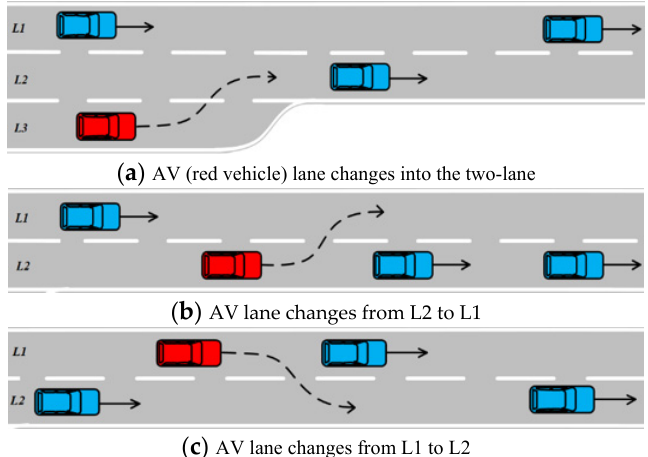
Figure 3. AV lane changing process.